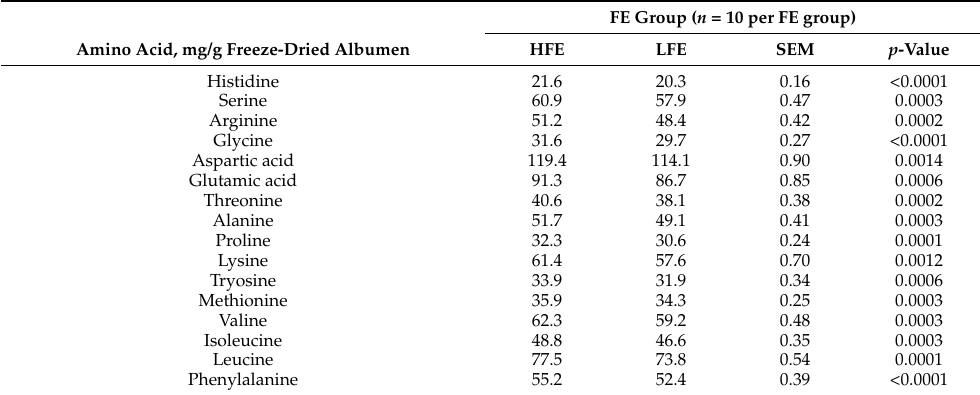
Table 3. The concentration of amino acids in egg albumen collected from high and low feed efficient ISA Brown hens in the mid stages of